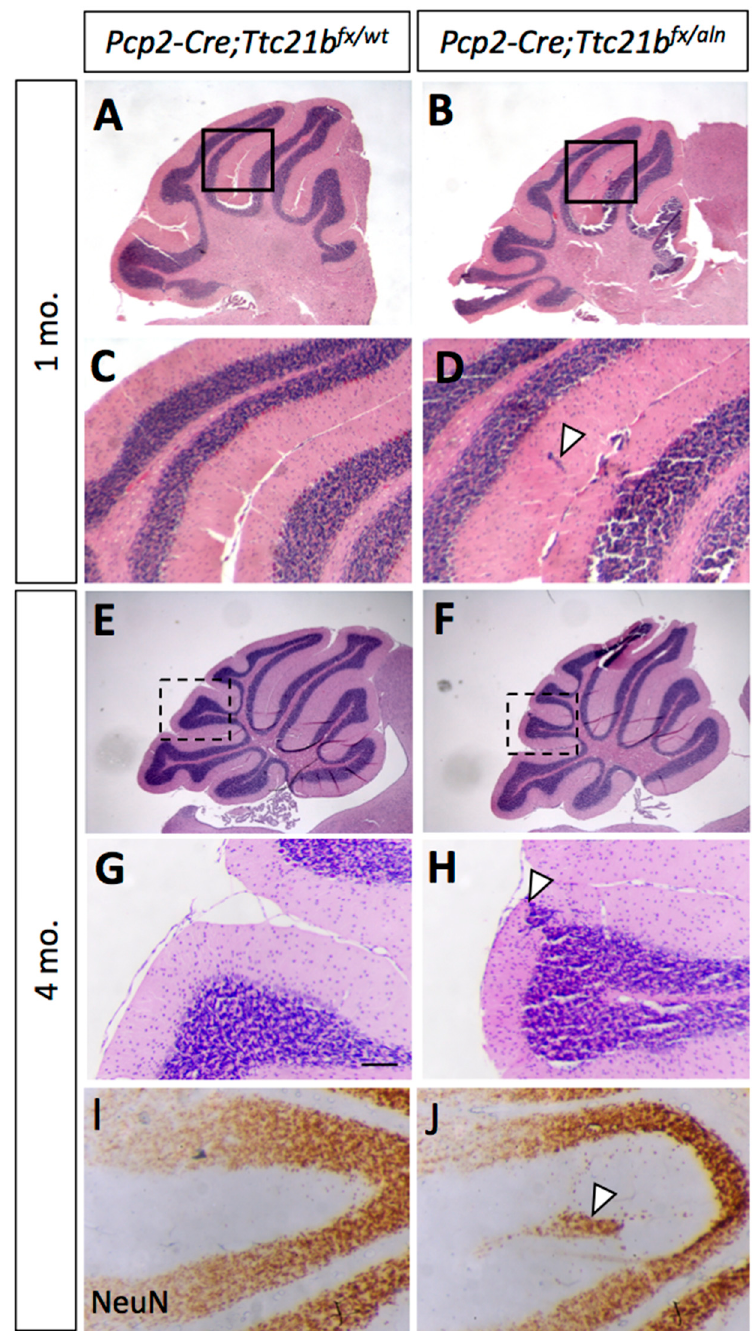
Figure 5. Ablation of Ttc21b with Pcp2-Cre results in similar, but milder, ectopic granule cell phenotype. ( A , B ) Small areas of displaced granule cells (arrowhead) are present in Pcp2-Cre;Ttc21b fx / aln brains at 1 month of age. ( B , D : boxes in A , B show areas highlighted in C , D ). ( E – I ) These cells are still visible at 4 months of age in the Pcp2-Cre;Ttc21b fx / aln animals ( H , arrowhead) and are immuno-positive for NeuN, indicating that these cells are differentiated granule cells ( J , arrowhead). n ≥ 3 for each genotype.